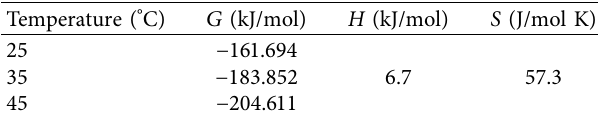
Figure 13: Van’t Hoff plot. Table 3: CV adsorption thermodynamic data onto Khulays’ nat- ural